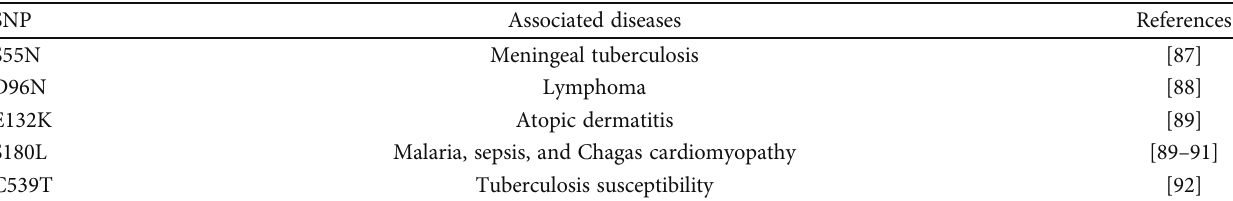
Table 2: Reported SNPs in the TIRAP